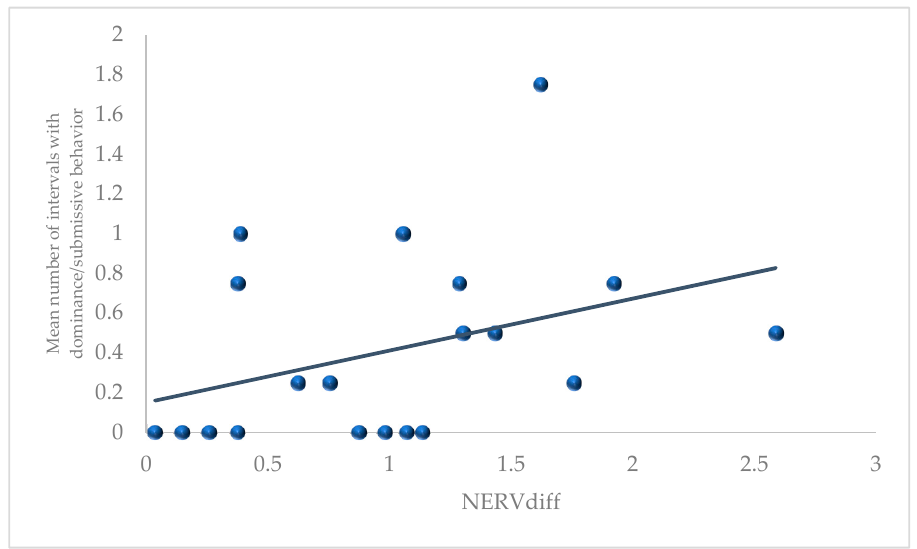
Figure 2. Correlation between difference in nervous temperament scores (NERVdiff) between social partners, measured in infancy and their mean number of intervals with observed domi- nance/submissive behavior averaged across the protected and continuous full contact stages, mea- sured in sub/adulthood. (Please note that the analysis was done on ranked data; however, the data presented here are